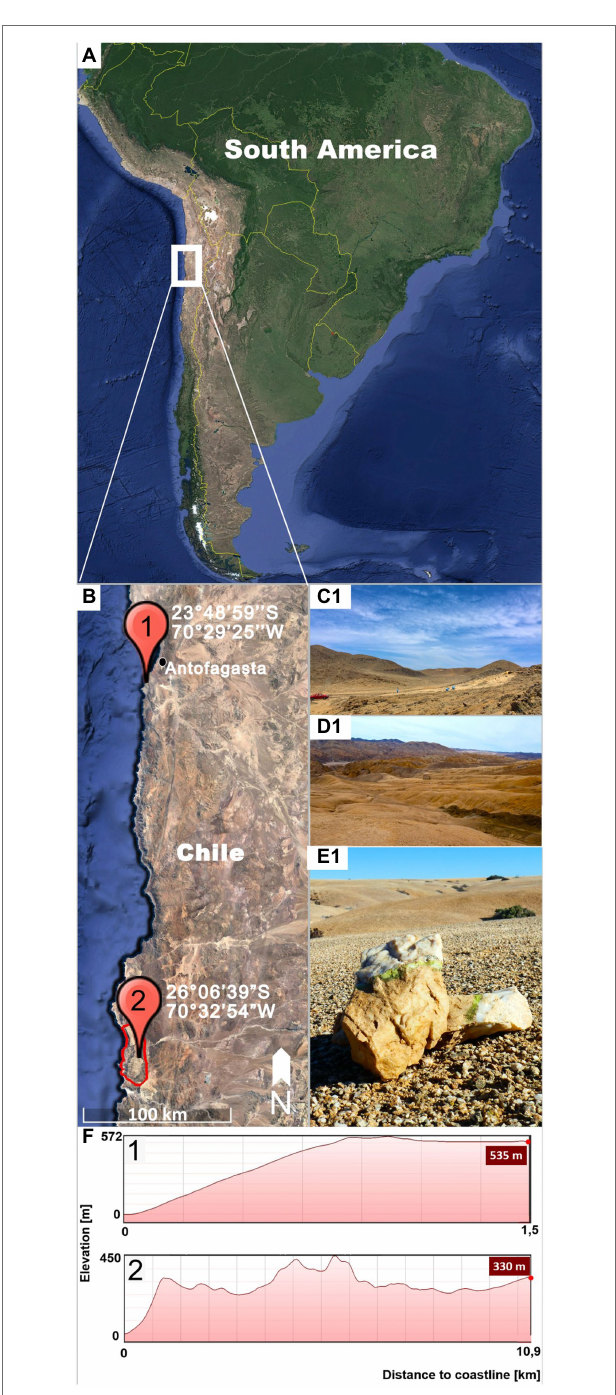
FIGURE 1 | Sampling locations. (A) shows on overview of South American indicating the location of the inspected region (white square). (B) Detail of the Coastal Range of the Atacama Desert showing the sampling sites of Gloeocapsopsis dulcis sp. nov. (marked with 1 ) and G. diffluens sp. nov. (marked with 2 ) in the National Park Pan de Azúcar (red circle). (C) Landscape of the sampling site (1) of G. dulcis sp. nov. (D) Landscape of the sampling site (2) of G. diffluens sp. nov. (E) Quartz stone showing green hypolithic biofilm from which G. diffluens sp. nov. was isolated. (F) Topography of both sampling sites (1,2) representing elevation and distance from